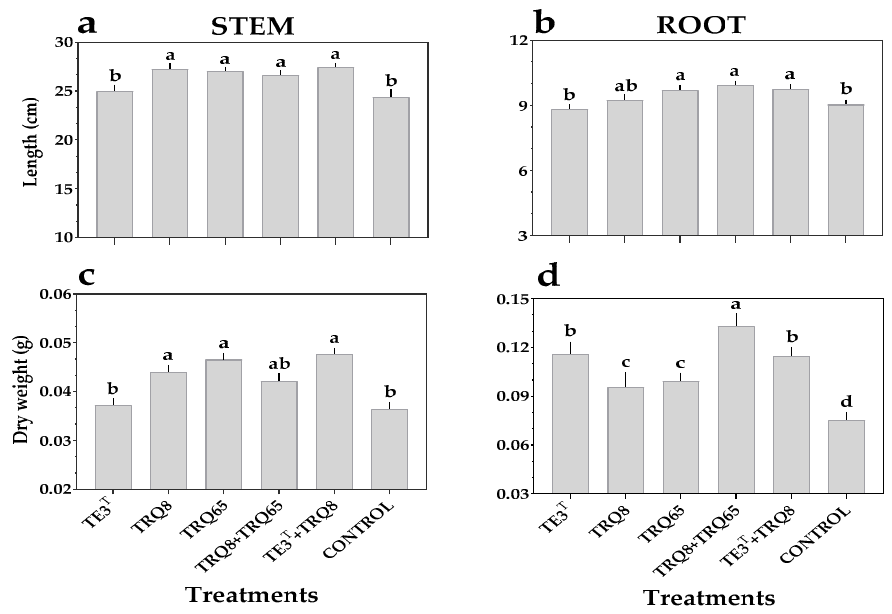
Figure 5. Wheat biometric effects by inoculation of Bacillus strains encapsulated in microbeads (individual or consortium) and control (empty microbeads) on ( a ) stem length, ( b ) root length, ( c ) stem dry weight and ( d ) root dry weight, after 30 days, under growth chamber conditions (13 h of darkness at 14 °C, 2 h of light at 18 °C, 7 h of light at 25 °C, and 2 h of light at 18 °C). Different letters correspond to treatments with significant differences according to Tukey HSD ( p ≤ 0.05). Bars indicate standard error.